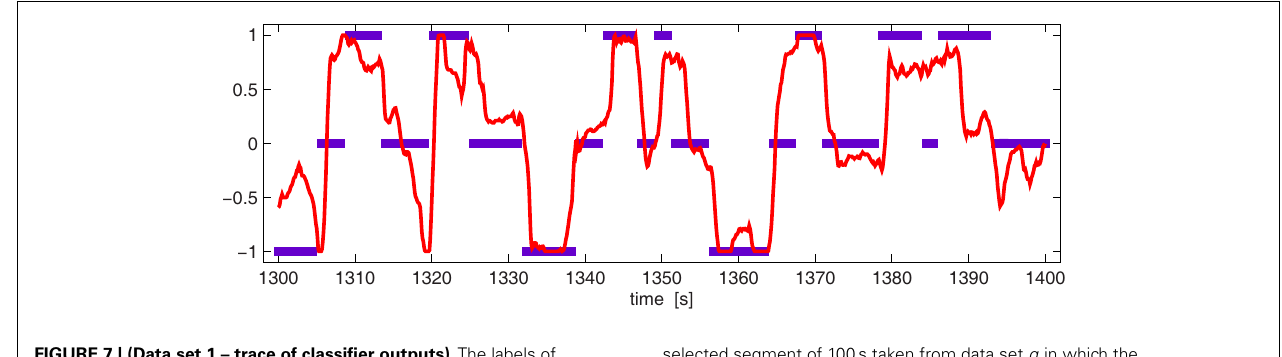
FIGURE 7 | (Data set 1 – trace of classifier outputs). The labels of the true mental state are displayed in blue.The red line shows the classifier outputs of the winning algorithm.This example is a